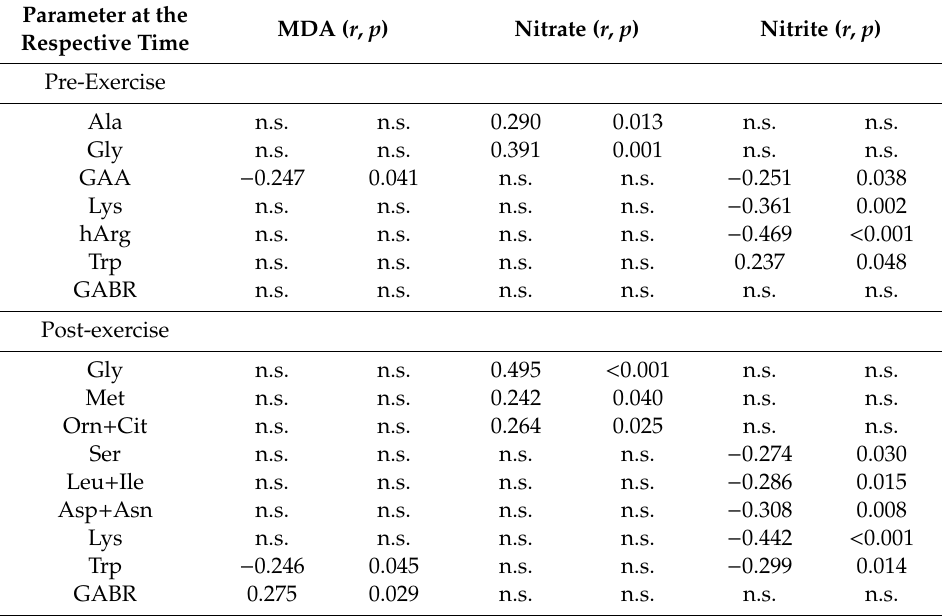
Table 4. Spearman correlation coe ffi cients ( r ) and p values of circulating amino acids with MDA, nitrate and nitrite in the combined groups.